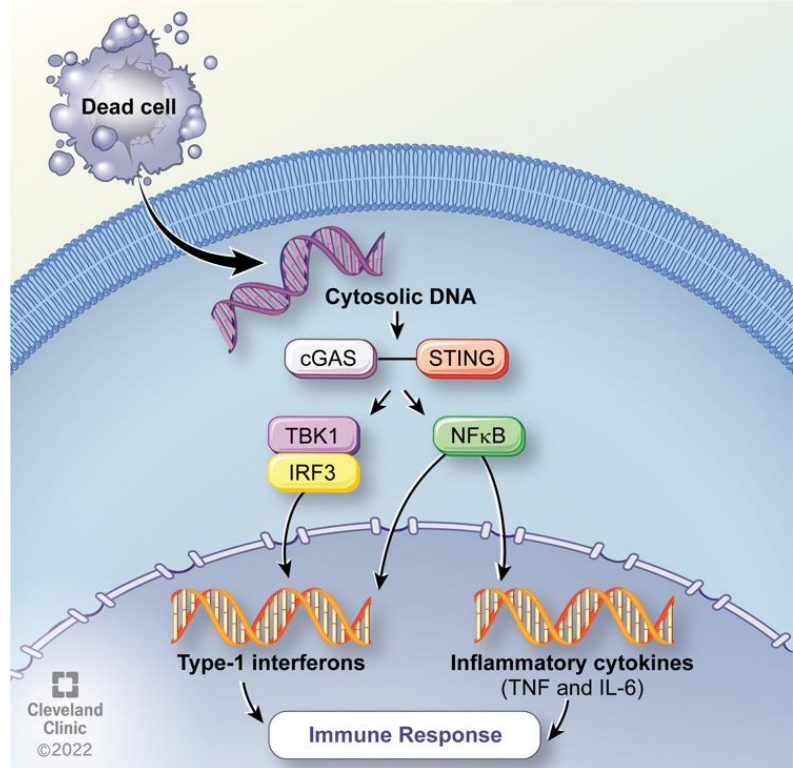
Figure 4. cGAS-STING pathway activation via detection of cytosolic DNA. Reprinted with permission, Cleveland Clinic Foundation ©2022. All Rights Reserved.